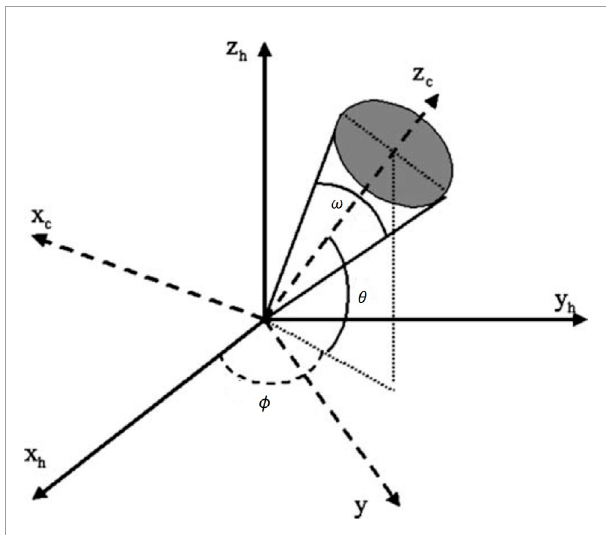
FIGURE 8 Cone model topology and relationship between the heliocentric coordinate system and the cone coordinate system (Michaek, 2006).